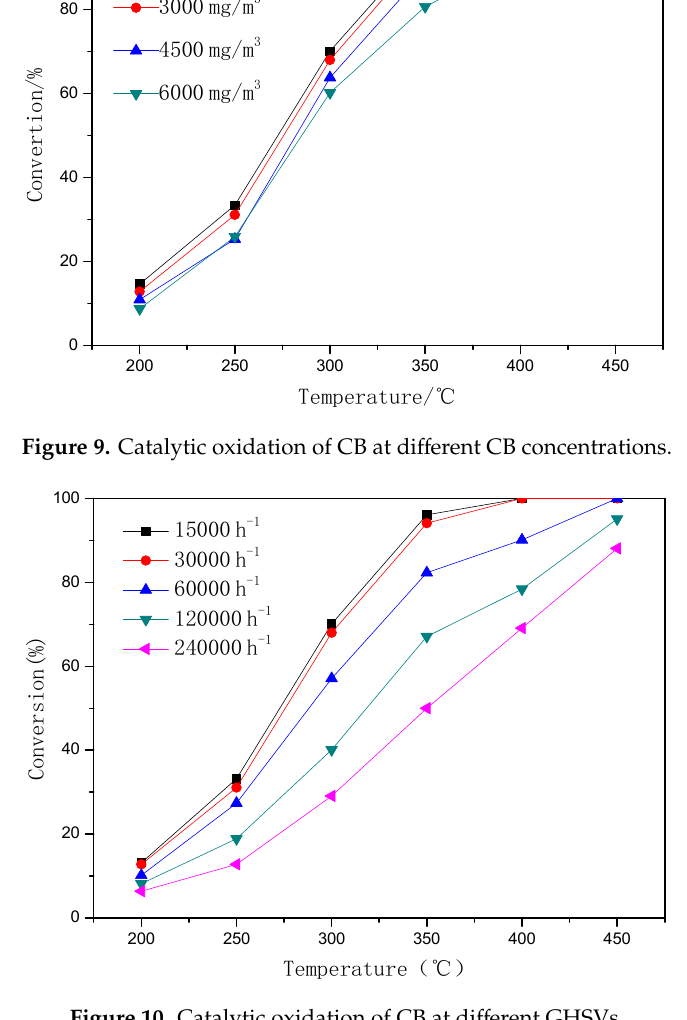
( b ) Figure 11. Cl − selectivity over two catalysts. ( a ) 0.2% Pd /TiO 2; ( b ) 0.2% Pd-0.5% Ce/TiO 2 To evaluate the generation of organic by-products, GC-MS was employed. The outlet gas was collected using an adsorption column for 30 min, followed by degassing the column in a thermal analyzer equipped with a GC-MS. Figure 12 and Table 3 show that during the catalytic oxidation of CB by the Pd/TiO 2 catalyst, polychlorinated benzene by-products were detected above 300 °C. Dichlorobenzene (DCB) was produced from 300 to 350 °C, and trichlorobenzene (TCB) was produced at 400 °C. The Pd-Ce/TiO 2 catalyst detected DCB from the beginning of the catalytic oxidation of the CB reaction, and DCB and TCB from 350 to 400 °C. As the temperature continued to increase, the by-products were no longer observed. According to the formation of organic